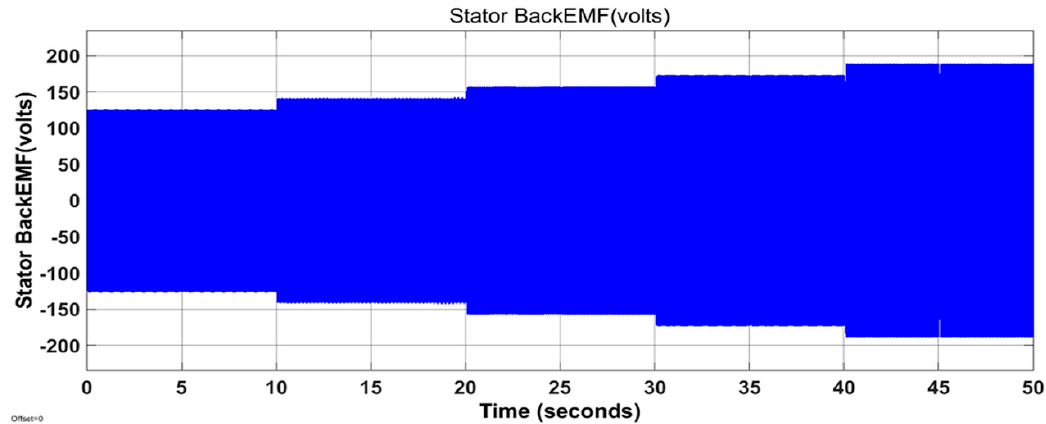
Figure 6. Back-Electro Motive Force waveform in phase A over 50 s.